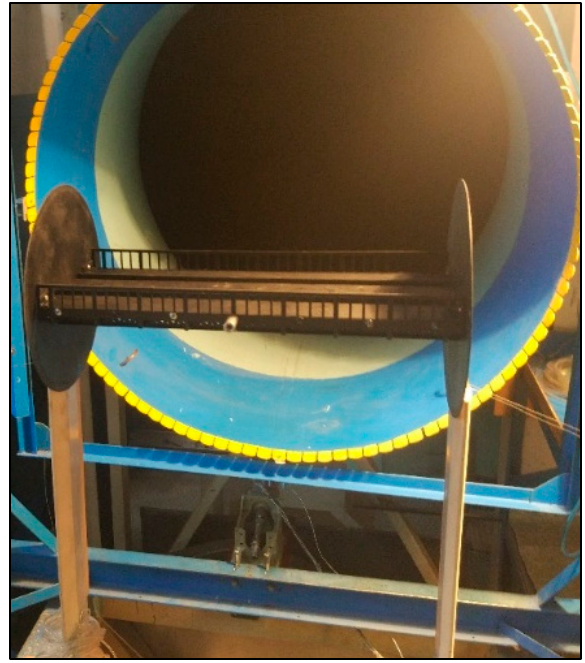
Figure 5. The sectional models fixed on the racks.